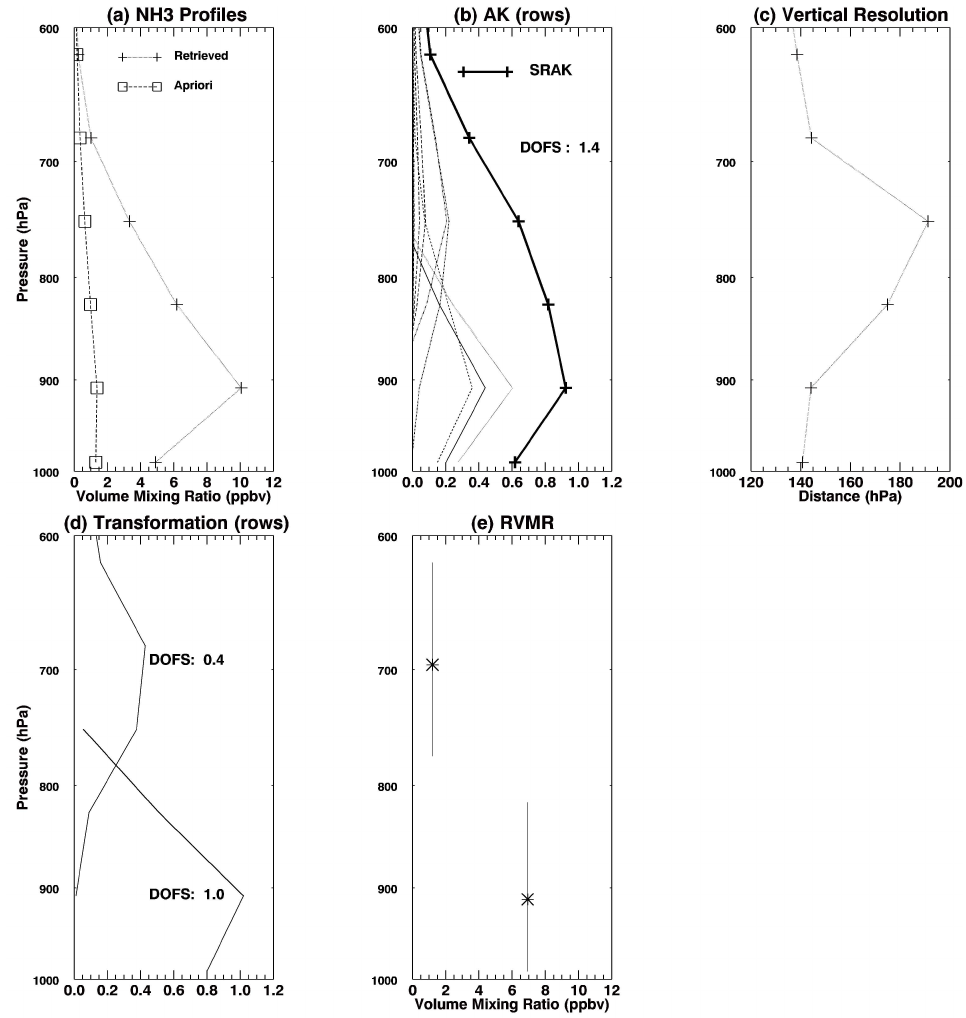
Fig. 18. These plots demonstrate the generation of the RVMR values from an example TES NH 3 retrieved profile where: (a) shows the example retrieved and a priori profiles; (b) the corresponding rows of the averaging kernel, with the sum of the rows of the averaging kernel (SRAK) in the thick solid line and reported degrees of freedom for signal (DOFS) for the example; (c) the vertical resolution at each of the retrieved levels; (d) the resulting rows of the transformation matrix used to produce the RVMR values; and (e) the resultant RVMR values marked with a star and vertical lines showing their